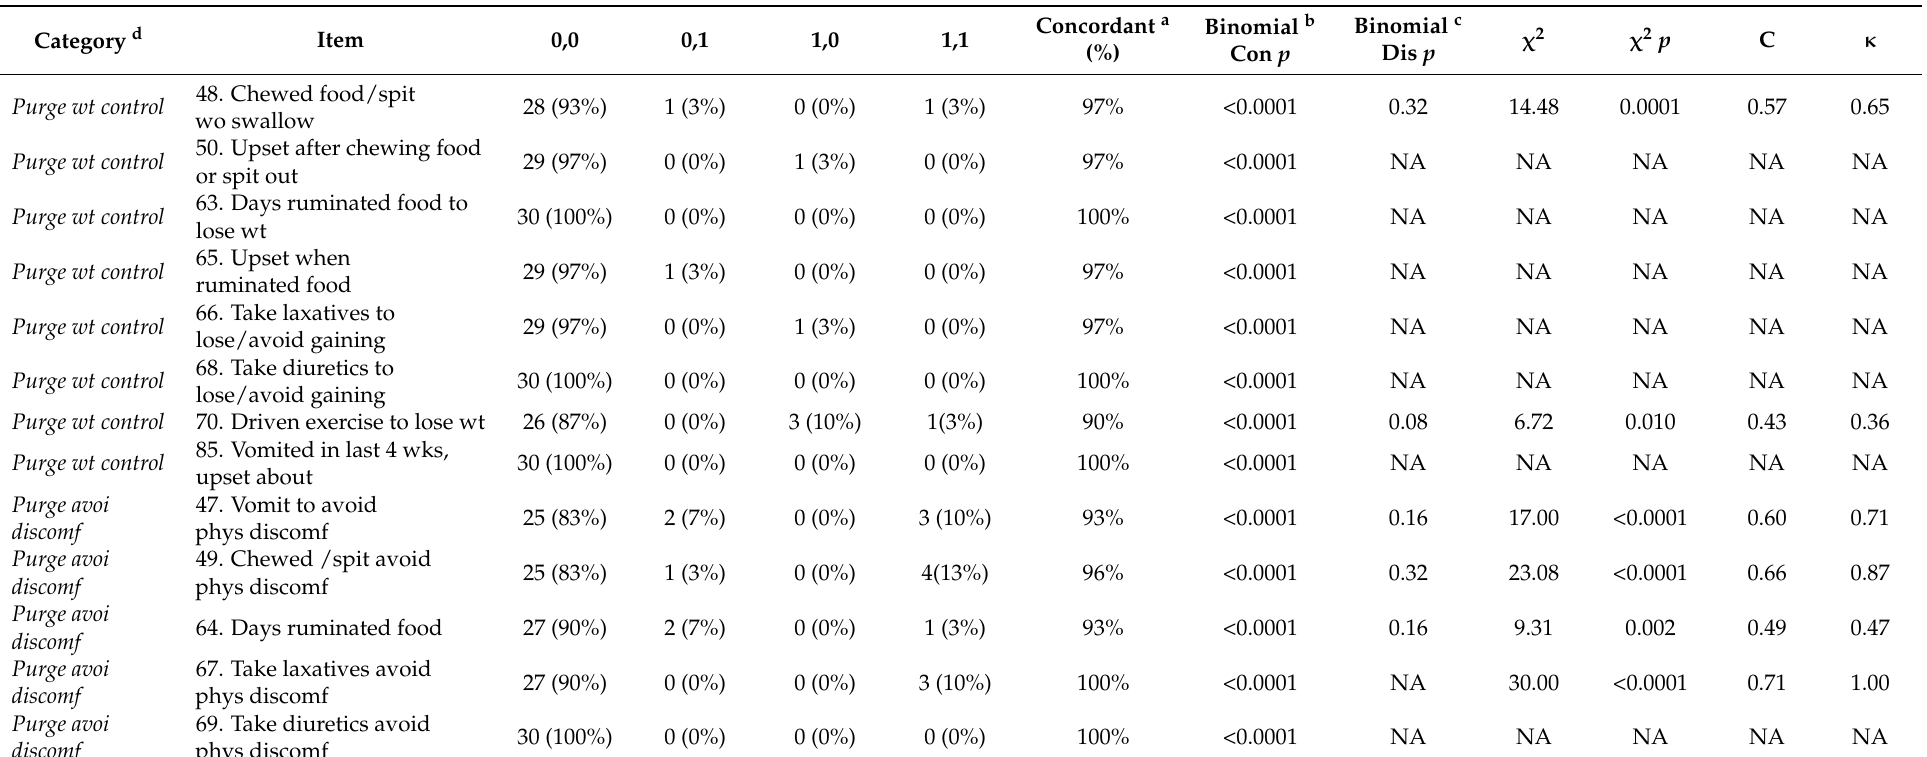
NA NA NA NA Table of within-subjects comparisons of binary responses between interview and questionnaire formats in bariatric surgery patients (N = 30) for the thirty dichotomous items. Items that are bolded are those in which χ 2 tests are appropriate. χ 2 p -values were held to Bonferonni correction for multiple comparisons (k = 21, α = 0.002). C, coefficient of contingency; κ , Cohen’s kappa statistic. a Concordant is the sum of percentages of concordant pairs (0,0 and 1,1) from the columns to the left. b Normal approximation of binomial tests were conducted on frequency of pairs by combining concordant pairs (0,0 and 1,1) to determine if the proportion of observed concordant pairs are due to chance (50%). p -values were held to Bonferonni correction for multiple comparisons (k = 41, α = 0.001). Con, concordant pairs. c Separate normal approximation of binomial tests were conducted on the discordant pairs (0,1, positive on interview and zero on questionnaire vs. 1,0, positive on questionnaire and zero on interview) to determine if participants were more likely to answer higher on the interview or questionnaire. p -values were held to Bonferonni correction for multiple comparisons (k = 21, α = 0.002). Dis, discordant pairs. d Category and item are abbreviated. Full text can be found in Table 1 and Appendix